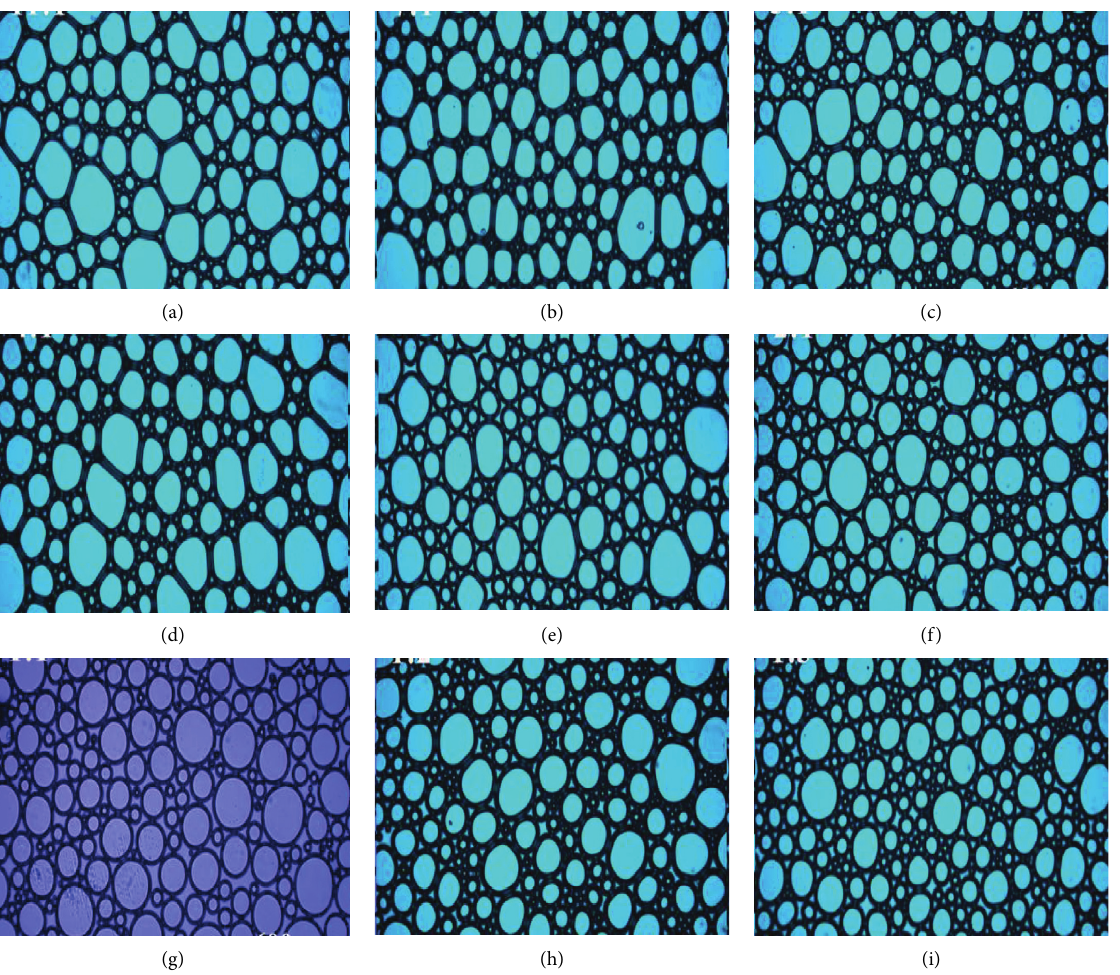
Figure 5: Microstructure of the foam under different surfactant mass ratios: (a) 11 :1; (b) 7 :1; (c) 5 :1; (d) 4 :1; (e) 3 :1; (f) 2 :1; (g) 1 :1; (h) 1 : 2; (i) 1 : 3.